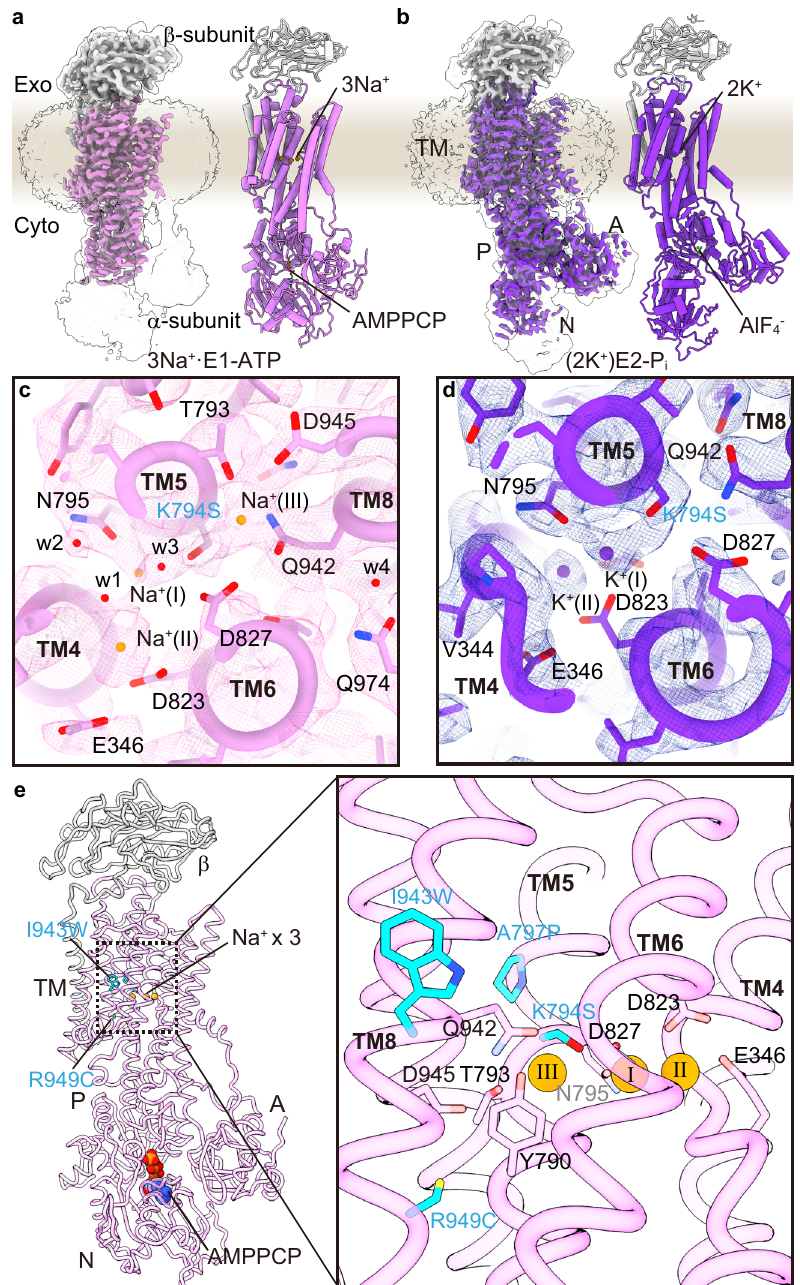
Fig. 6 | Cryo-EM structure of NKA-like SPWC-ngHKA. a , b EM potential maps (coloredsurfacesindicatehighercontourlevel,whiletransparentsurfacesindicate lower levels with micelle and cytoplasmic domains visible) and cartoon models of the SPWC-ngHKA mutant in the presence of 300mM Na + and 5mM AMPPCP to induce the 3Na + ·E1-ATP state ( a ), and with 100mM KCl and 1mM AlF 4 − to lock the pump in the E2-P i state ( b ). The β -subunit is shown in gray and the α -subunit in pink,forE1,andpurple,forE2.Boundionsareshownasorange(Na + )orpurple(K + ) spheres. See Fig. 7 for comparison with NKA structures. c Cytoplasmic view of the